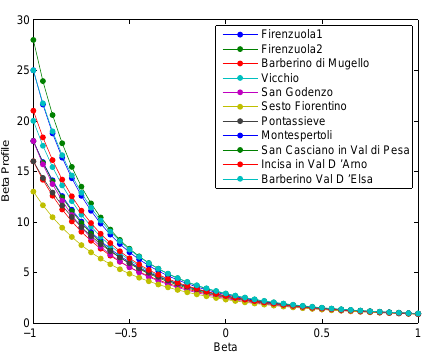
Figure 3 – β -profiles ( △